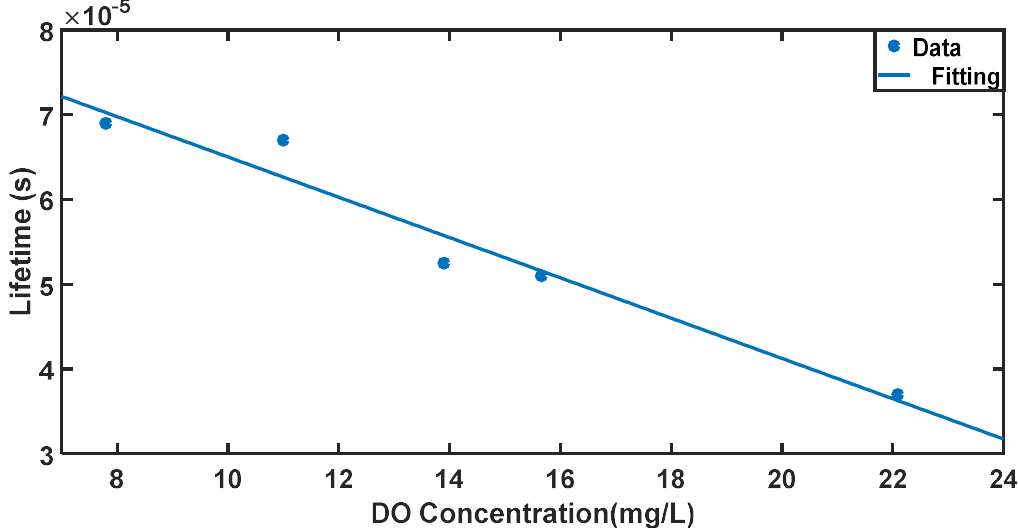
Figure 7. Linear relation between fluorescence lifetime and DO concentration at DO range from 7.8 to 22 mg/L.